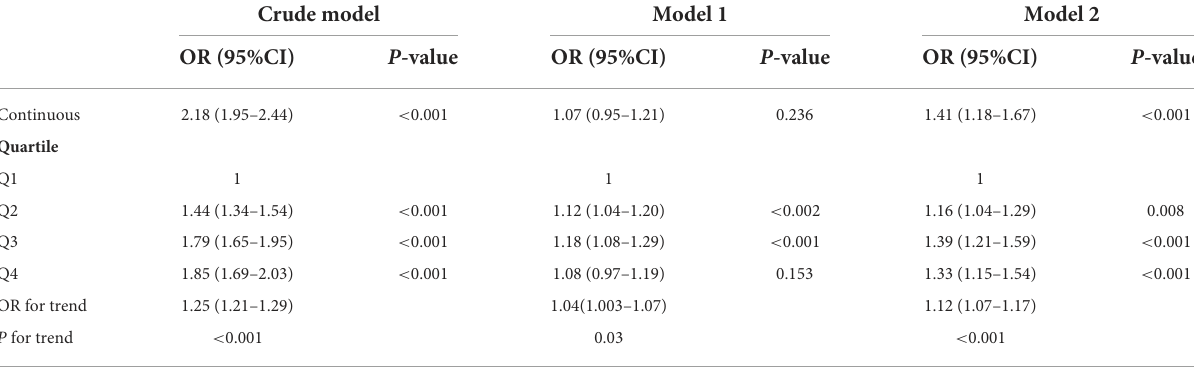
TABLE 2 Association between blood Pb and hyperlipidemia among US adults in NHANES